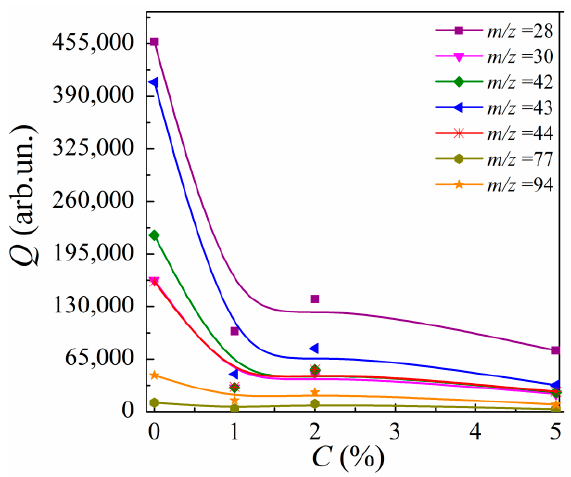
Figure 8. Concentration dependences of the output 𝑄 for volatile thermal desorption fragments with m / z = 28, 30, 42, 43, 44, 77, and 94 for MLG–epoxy